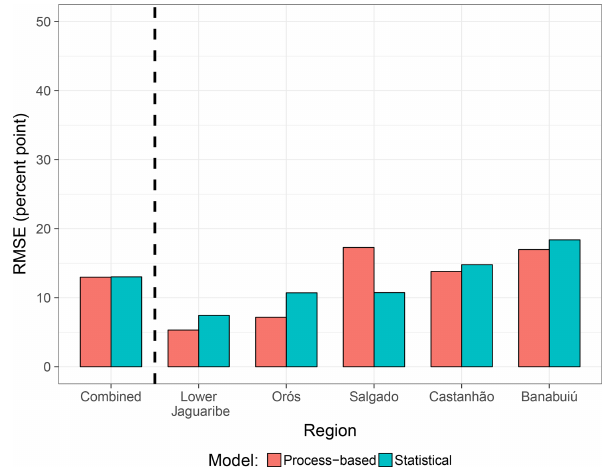
Figure 3. Comparison of accuracy in predicting relative reservoir storage for the process-based and statistical model in simulation mode (i.e. run with observed forcing). The underlying analysis pe- riod comprises monthly values of the rainy season (January to June) over the hindcast period (observations available since 1986 un- til 2014 with some data gaps in between, resulting in a maximum of 174 values for each